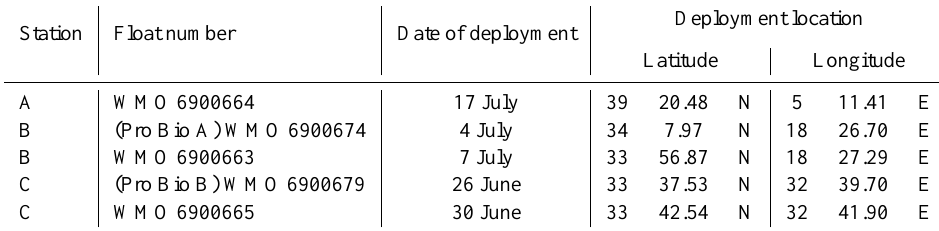
Table 2. PROVOR ARGO floats deployed along the BOUM transect at the three pre-defined LD stations (A, B, C).